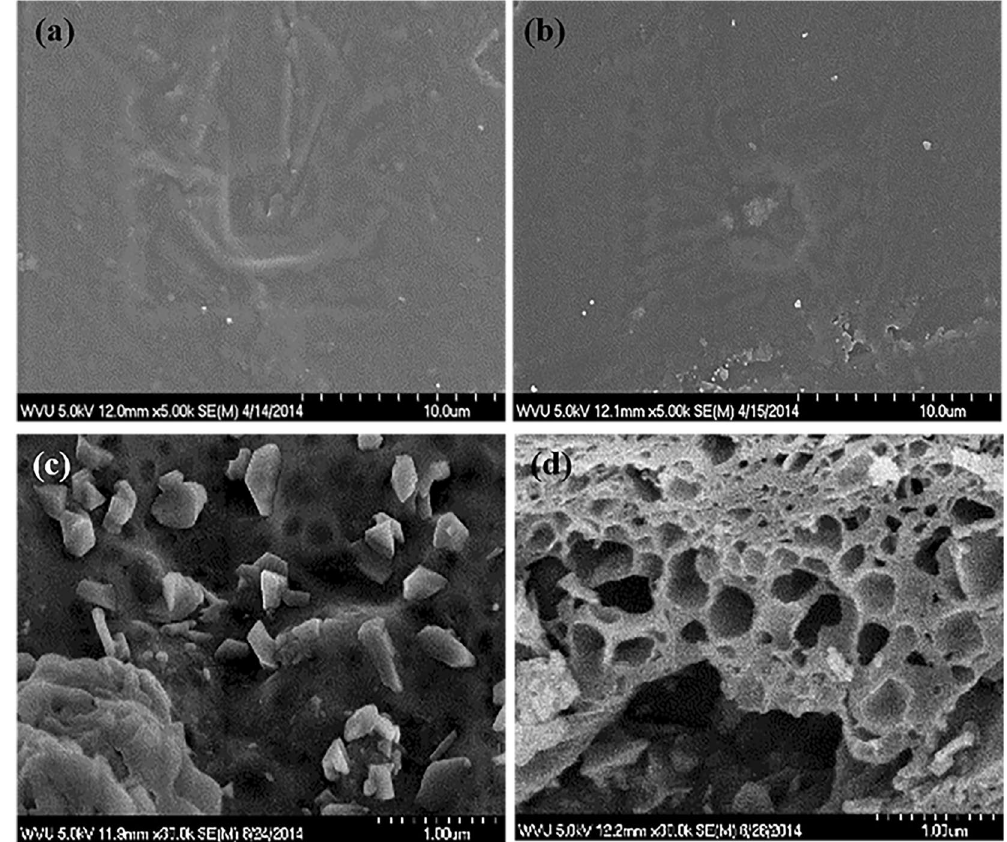
Figure 3. Surface morphology of ( a ) PLA, ( b ) PLACC, and ( c ), ( d ) the two morphologies displayed by PLACC900 as determined by